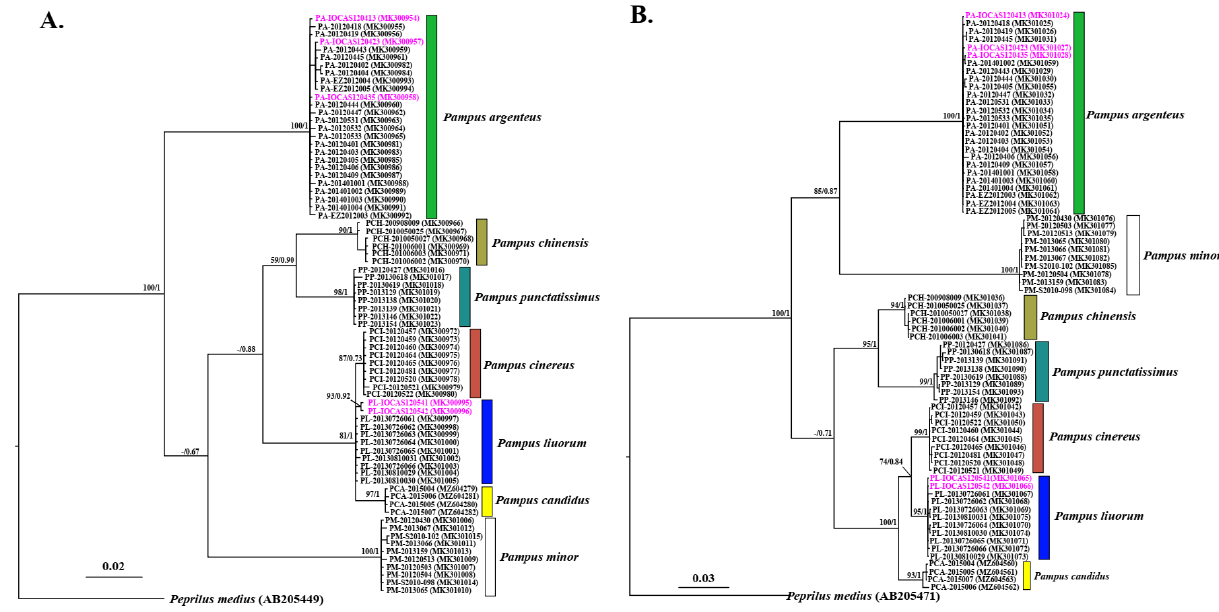
Figure 3. Maximum likelihood tree of the Pampus species inferred from COI ( A ) and Cyt b ( B ) datasets. Bootstrap values (before slash) and posterior probabilities (after slash) are shown on each node; “-” on the node indicates that the node was not included in the maximum likelihood or Bayesian analyses. Specimens in purple are specimens derived from Liu and Li [2] and Liu et al. [3].